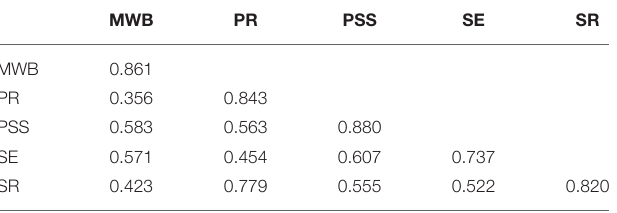
TABLE 2 | Model assessment (direct model).